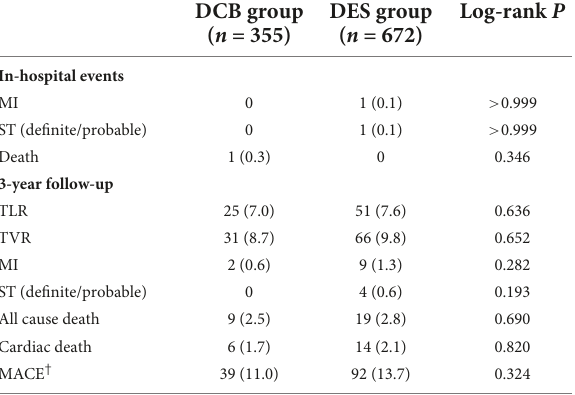
TABLE 5 Cumulative clinical